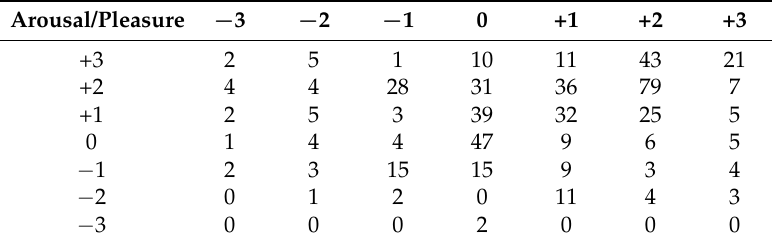
Table 4. The sample size of each square of circumplex of model of affect.